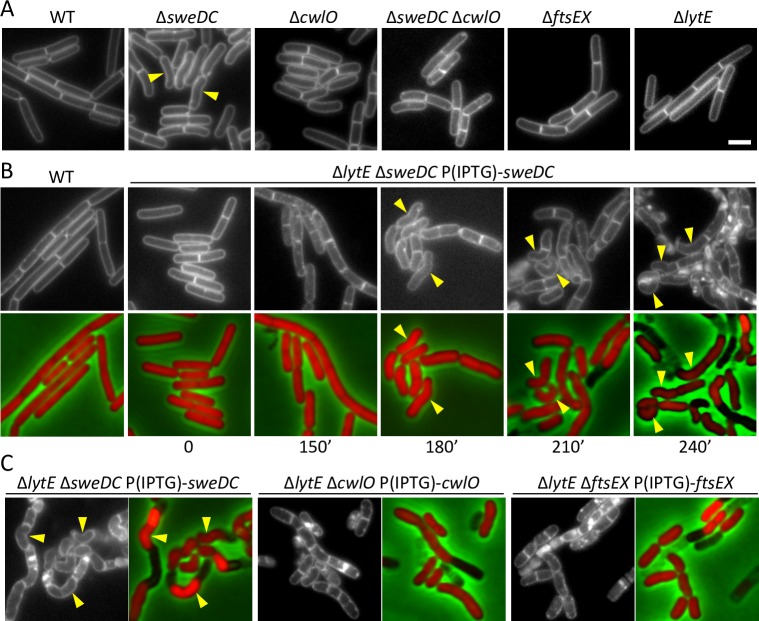
ΔsweDC mutants have morphological defects that resemble ΔcwlO and ΔftsEX.(A) Representative images of wild-type (WT) (BDR2649), ΔsweDC (BYB370), ΔcwlO (BYB371), ΔsweDC ΔcwlO (BYB374), ΔftsEX (BYB372), and ΔlytE (BYB373) are shown. Exponentially growing cells in CH medium were stained with the membrane dye TMA-DPH and examined by fluorescence microscopy. (B) Representative images of a ΔlytE strain during depletion of SweDC. The indicated strain (BYB362) harboring cytoplasmic mCherry was grown to exponential phase in CH medium in the presence of 500 μM IPTG, washed twice with medium lacking inducer, and used to inoculate CH medium at an OD600 of 0.05. The cells were examined by fluorescence microscopy at the indicated times. Membranes were visualized with TMA-DPH (top) and cytoplasmic mCherry and phase contrast (bottom). (C) Comparison of the terminal phenotypes of strains lacking LytE and depleted of SweDC (BYB362), CwlO (BYB279), or FtsEX (BYB439) The indicated strains were grown to exponential phase in the presence of IPTG (500 μM), washed twice with medium lacking inducer, back-diluted to an OD600 of 0.05 (BYB362, BYB439) or 0.1 (BYB279) in CH medium, and grown to mid-exponential phase in the absence of inducer. Cells were examined by fluorescence microscopy. Images of SweDC, CwlO, and FtsEX depletions are from 230, 60, and 150 min after removal of IPTG, respectively. The different times required to reach the terminal phenotype likely reflect the abundance and half-lives of the individual proteins. All strains contained cytoplasmic mCherry, and an overlay of mCherry and phase contrast is shown adjacent to TMA-DPH-stained membranes. The representative images in this figure are from one of three independent experiments. Curved cell morphologies are highlighted (yellow carets). Scale bar indicates 2 μm.